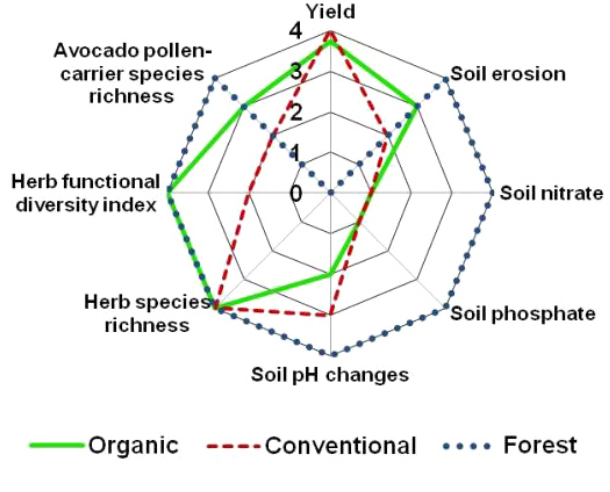
Fig. 5. Multivariate trade-offs in avocado agroecosystems in the P’urhépecha plateau,